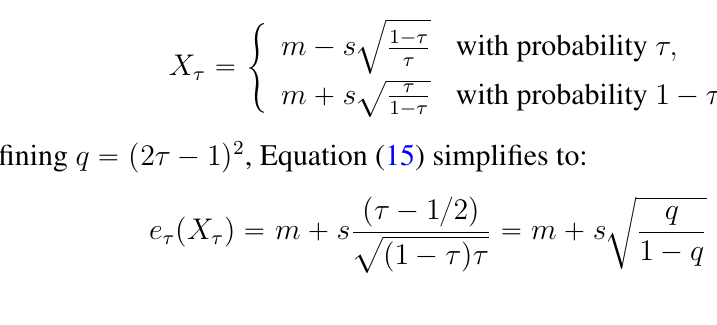
Figure 1. Expectile e function of p P p 0 , 1 q . The maximum is attained at p “ τ ; the minimum is approached as p Ñ 0 or p Ñ 1